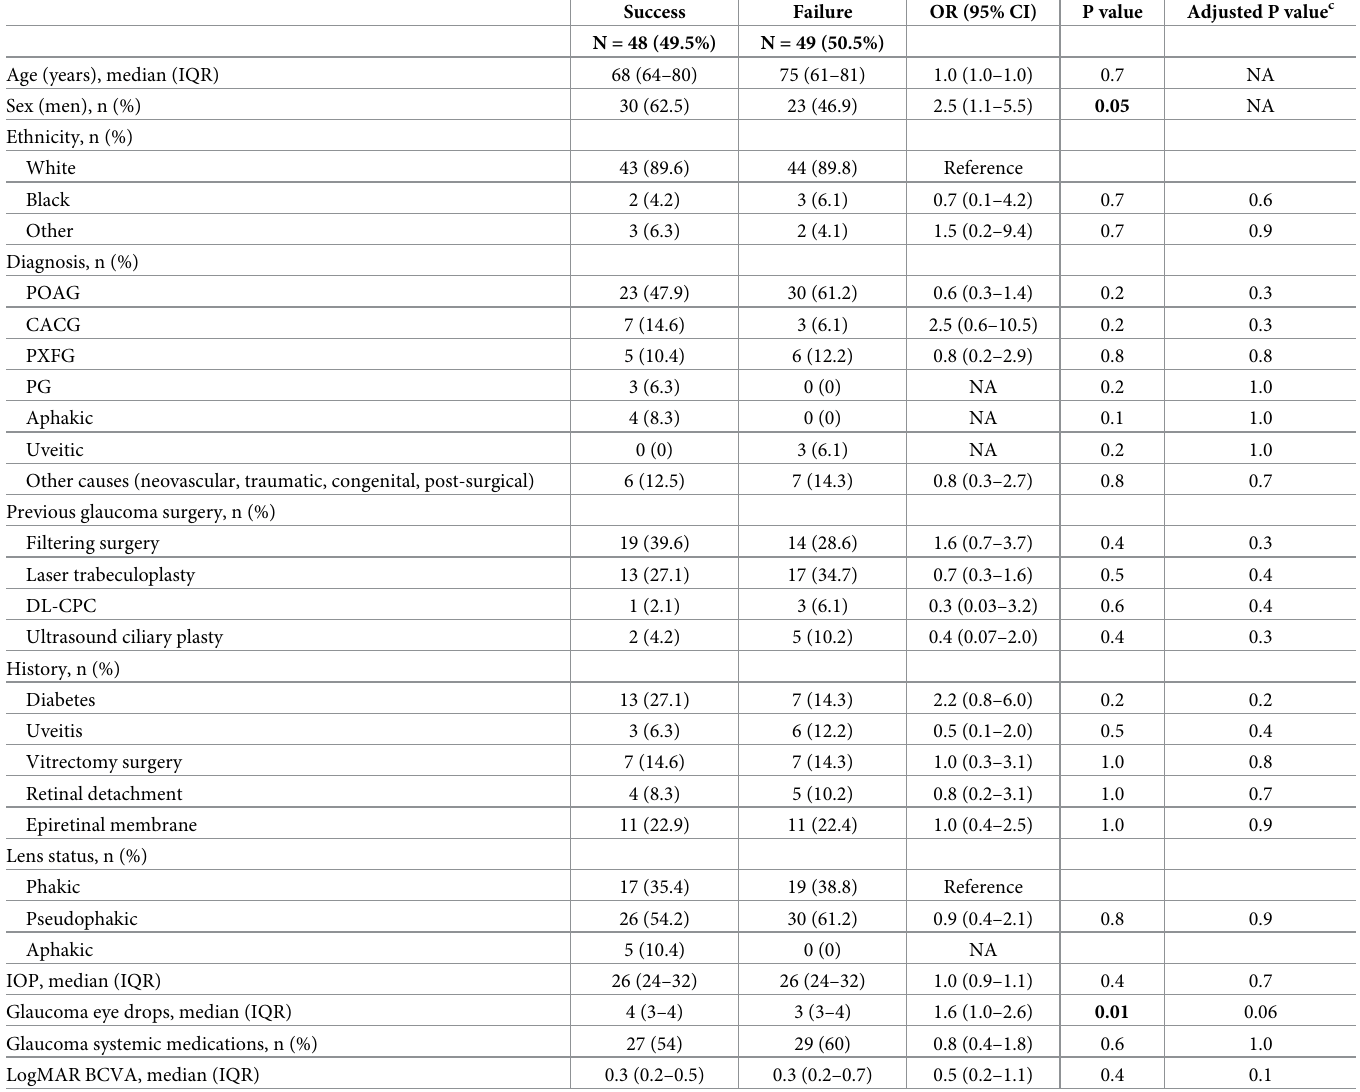
Table 1. Baseline characteristics of patients according to surgical success a or failure b